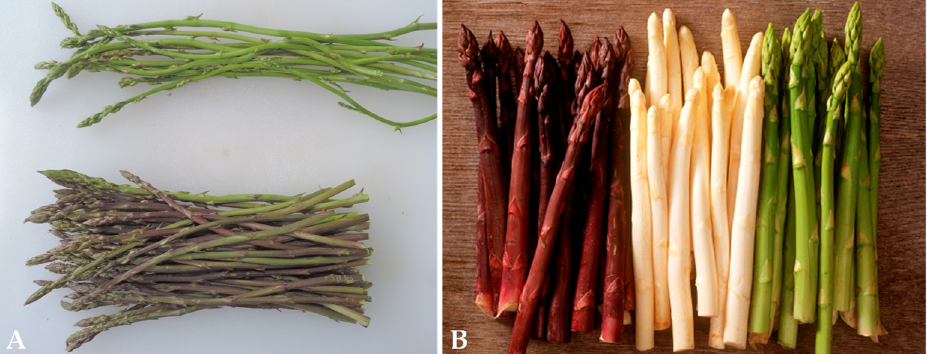
Figure 1. ( A ) Wild violet (below) and wild green (above) asparagus. ( B ) ‘Purple Passion’ (left), ‘Bianco di Bassano del Grappa’ (center), and ‘Grande’ (right) cultivars of cultivated asparagus.